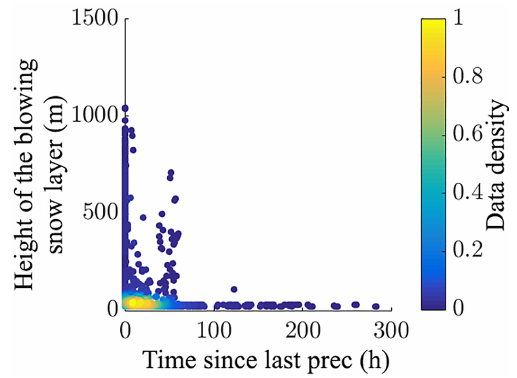
Figure 12. Scatter plot of the time since last precipitation event vs. height of the blowing snow layer at PE station. Each point repre- sents a blowing snow event. The color bar represent the data density (number of observations divided by the entire sample